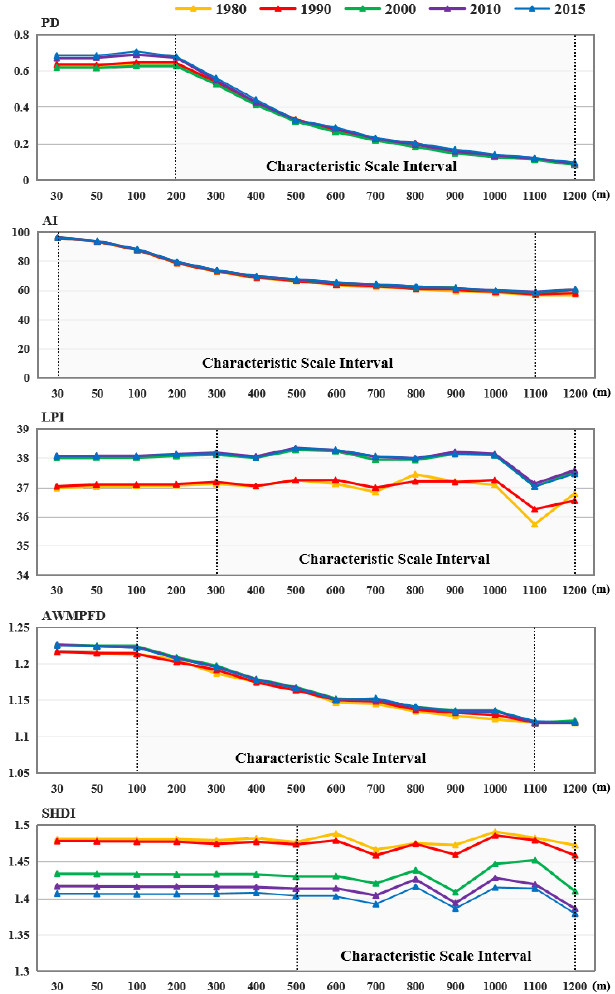
Figure A2. Analysis results of the characteristic scale interval in 14 different granularities.